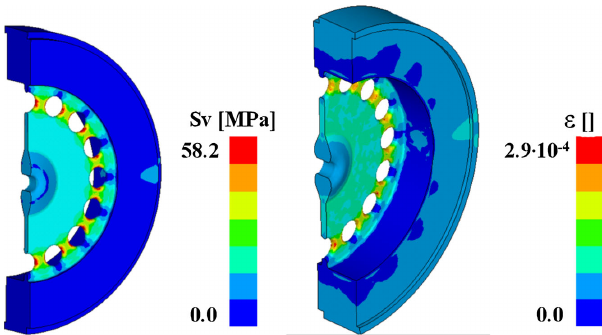
FIG. 20. Von Mises stress (left) and the first principal total strain (right) maps of the cell #12 at the end of the fifth